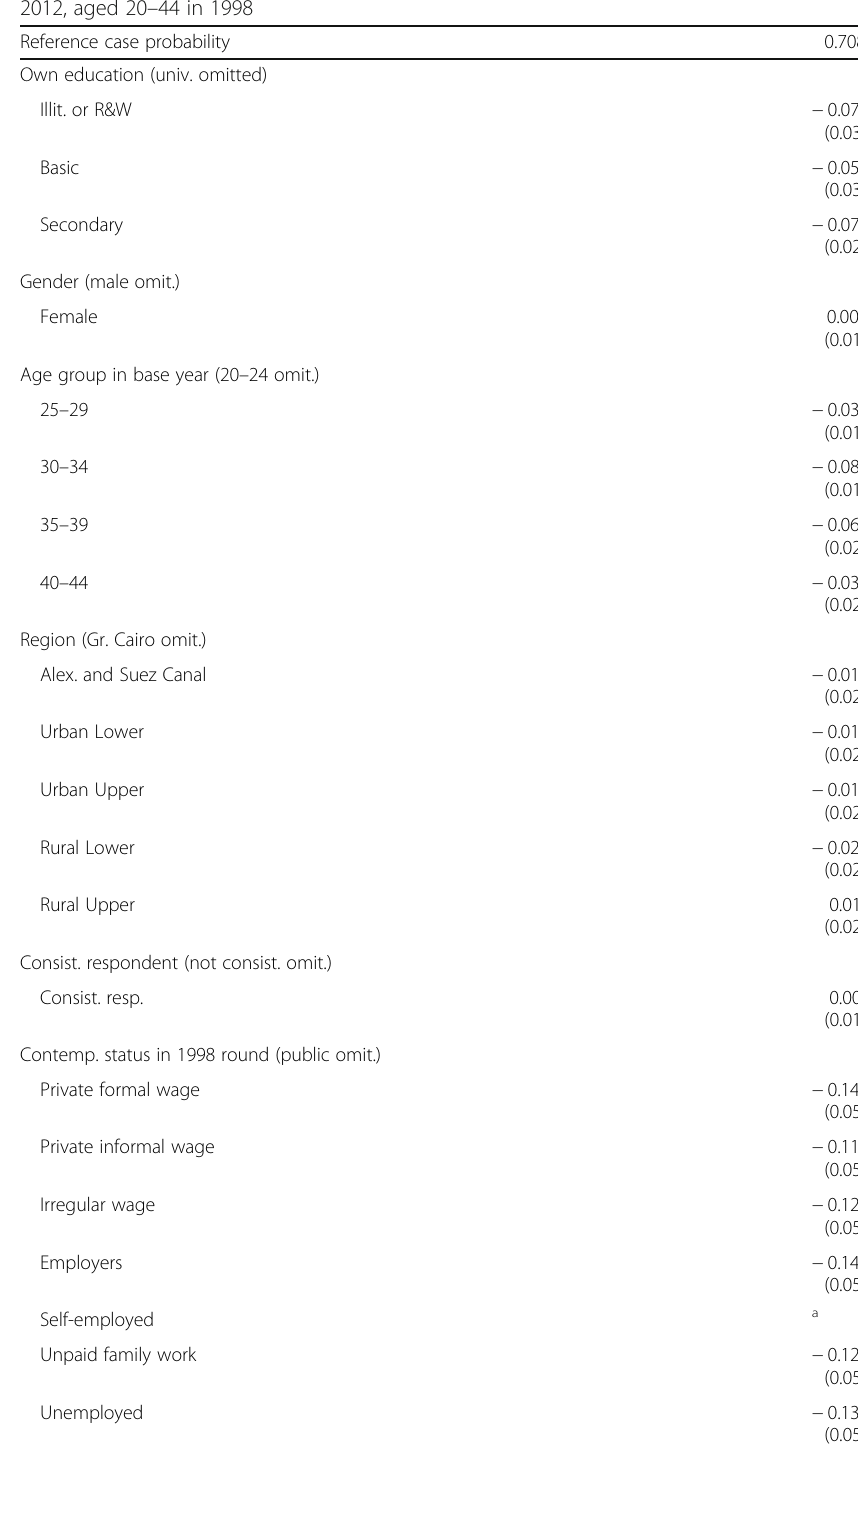
Table 4 Probit model marginal effects for the probability of alignment of reporting a specific type of transition from 1998 to 2006, as calculated using contemporaneous 1998 and 2006 panel data and as calculated using 2012 retrospective data by sex, individuals observed in 1998, 2006,